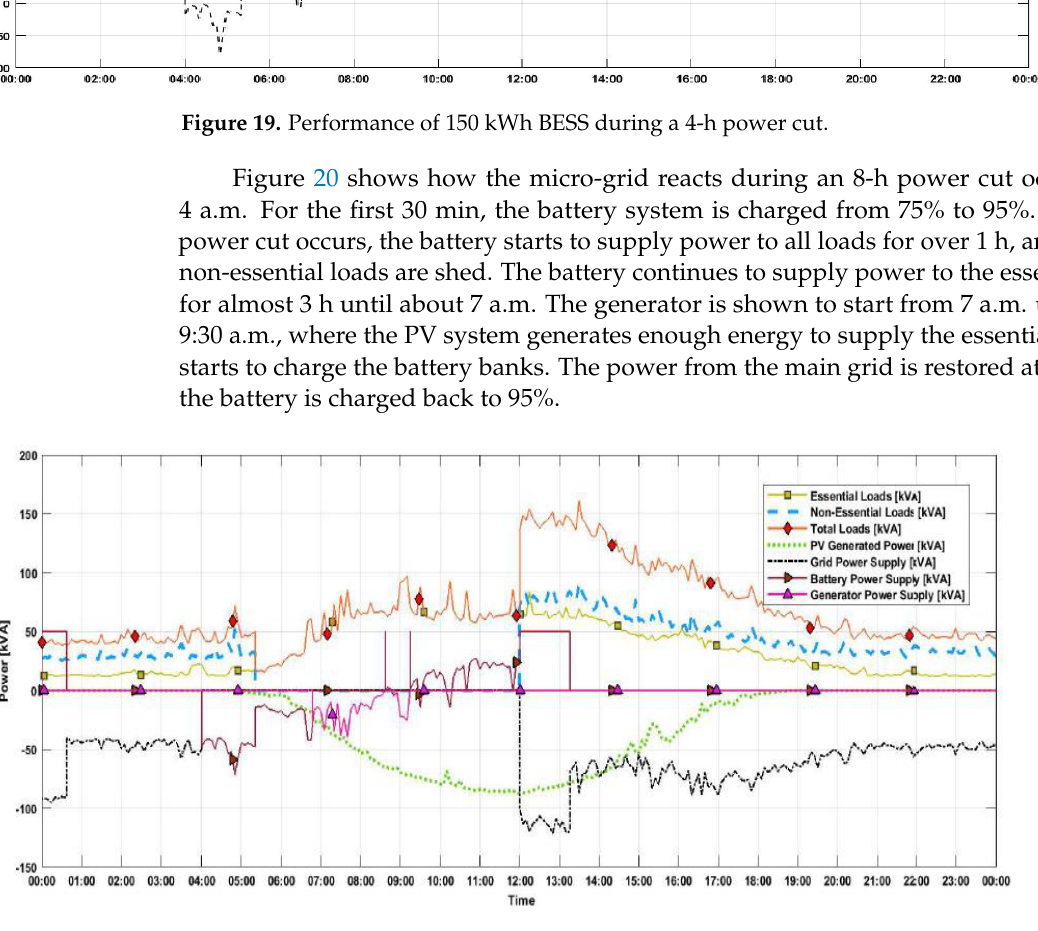
Figure 19. Performance of 150 kWh BESS during a 4-h power cut.